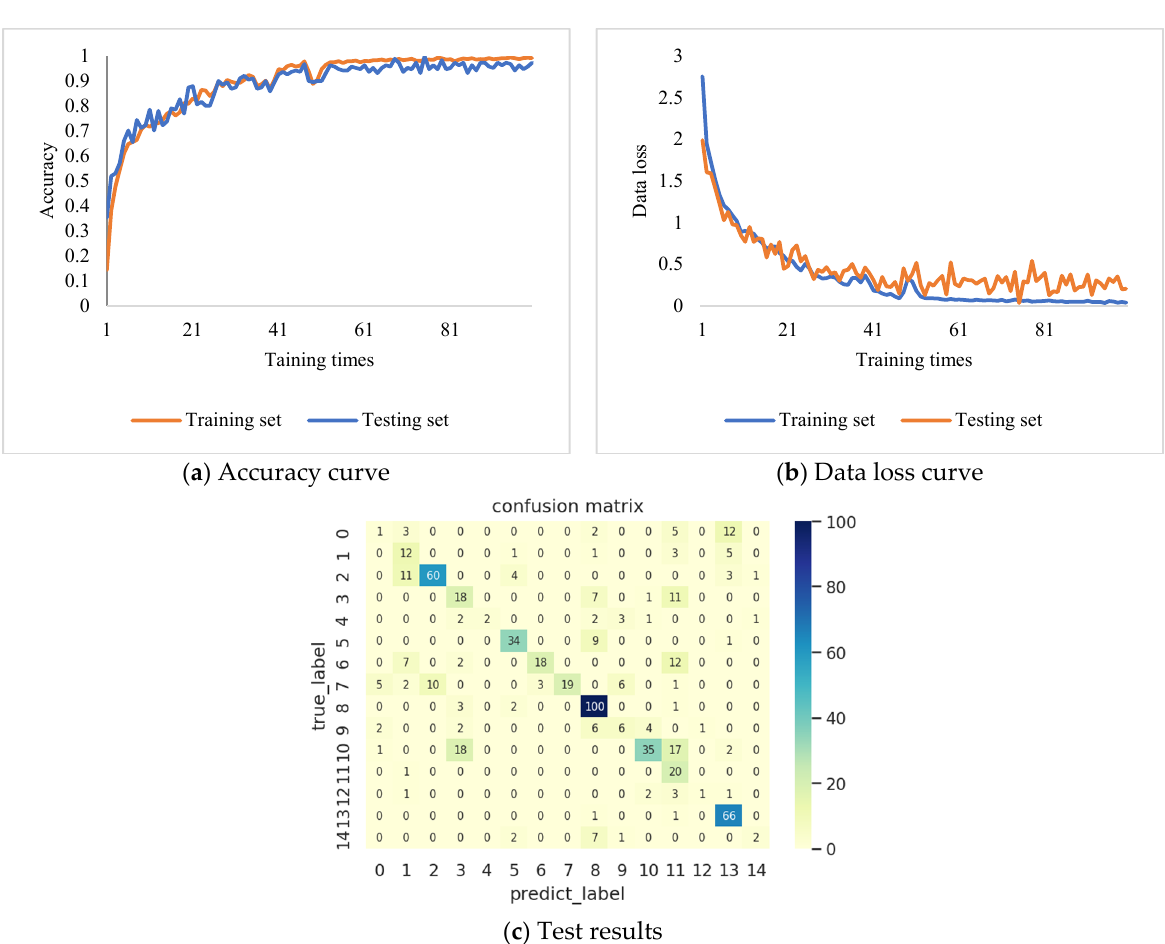
Figure 17. Training results of the transfer learning model based on the MobileNet model.